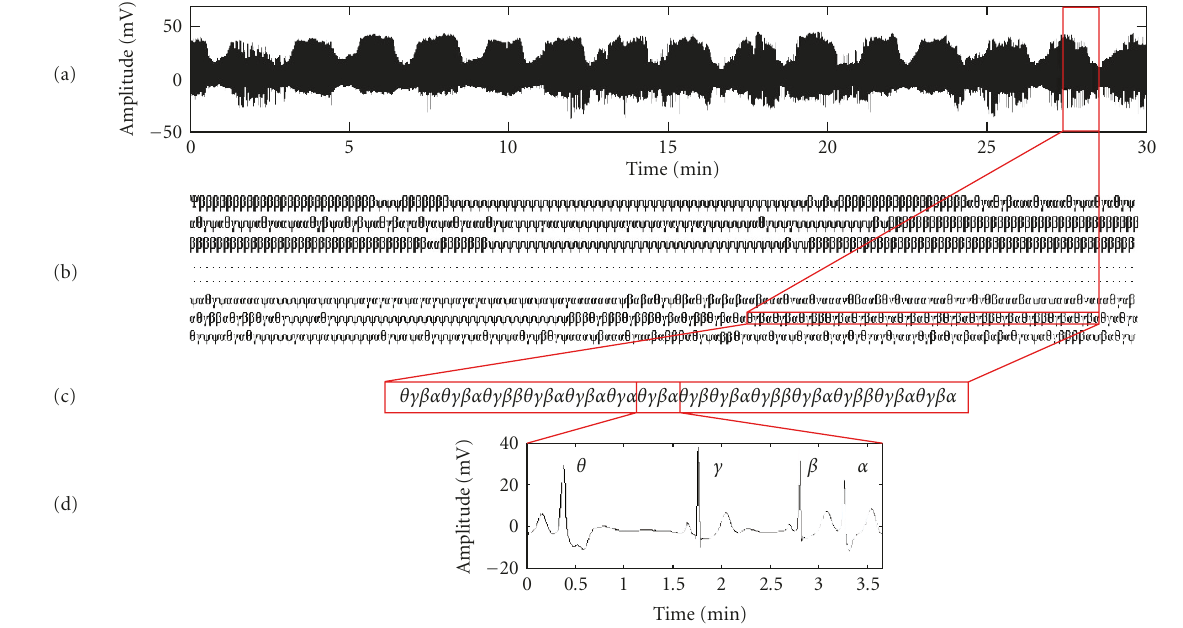
Figure 1: Overview of symbolic analysis: (a) raw data corresponding to Patient 106 in the MIT-BIH arrhythmia database. The red rectangle denotes a particular pattern hidden within the raw data. This pattern is di ffi cult to identify by visual examination alone. (b) The raw ECG data is mapped into a symbolic representation (11 lines of the symbol sequence are elided from this figure). (c) An example rhythm of a repeating sequence, found in the symbolized representation of the data corresponding to the boxed area of the raw data in (a). (d) An archetypal representation, created using the techniques in [3], of the repeating